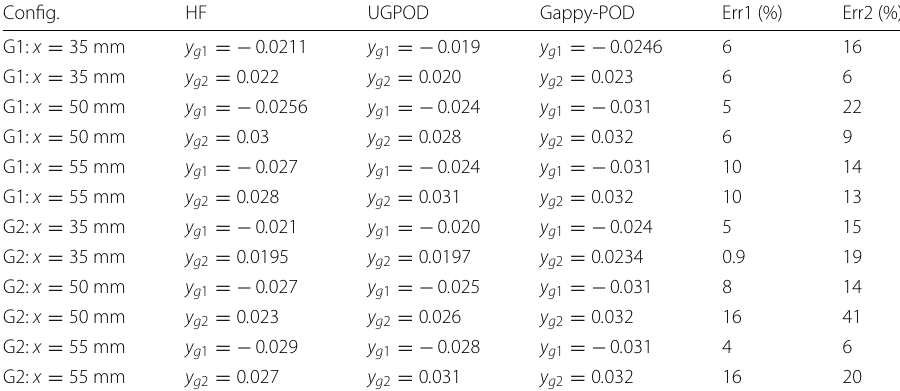
Table 2 Evaluation of the position of the recirculation zones of the two new geometries and their relative errors, Err1 for our method and Err2 for the Gappy-POD, with respect to the LES ones Config. HF UGPOD